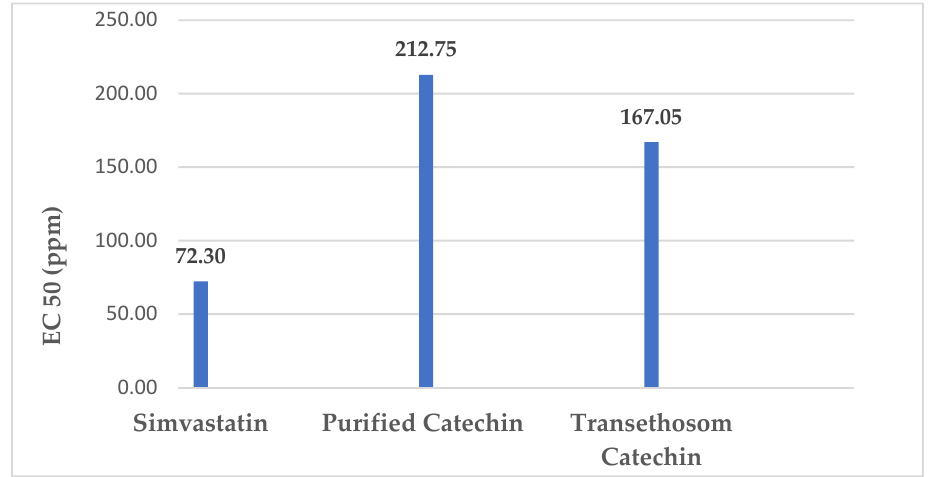
Figure 7. In vitro study of anticholesterolemic of cathechin performed to determine EC50 of Purified Catechin, Transethosom Catechin compared to Simvastatin. Transethoson cathechin formula enhanced the EC50 close to simvastatin as reference drug more effective than purified catechin.